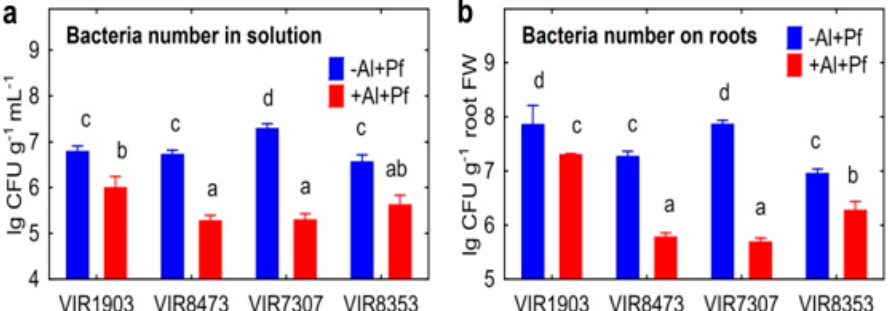
Figure 5. The number of Pseudomonas fluorescens SPB2137 in the nutrient solution ( a ) and on roots ( b ) of pea genotypes VIR1903, VIR8473, VIR7307 and VIR8353 untreated and treated with 80 µM AlCl 3 . Treatments: − Al+Pf—Al-untreated and inoculated plants, +Al+Pf—Al-treated and inoculated plants. Vertical bars show standard errors. Different lowercase letters show significant differences between treatments (least significant difference test, p < 0.05, n varied from 4 to 12 depending on pea genotype and treatment). FW stands for fresh weight. CFU stands for colony-forming units.